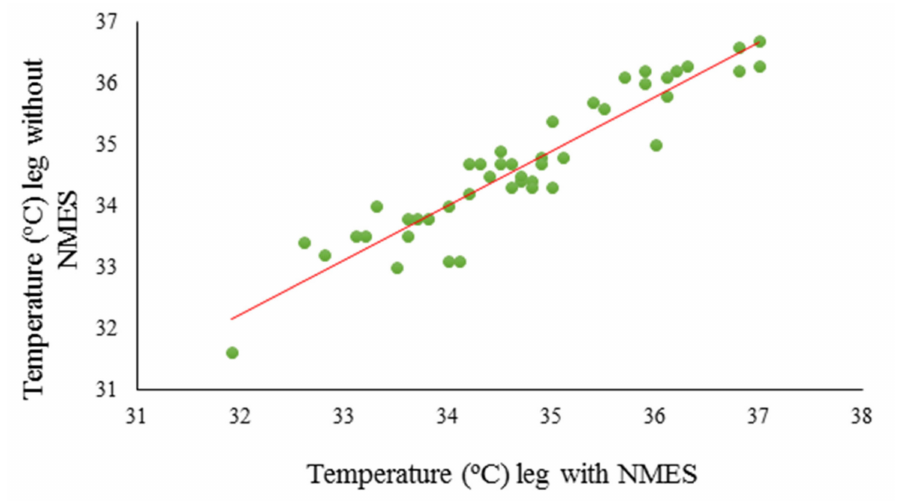
Figure 3. The temperature value of the leg that does not receive NMES can be predicted using the temperature value of the leg with